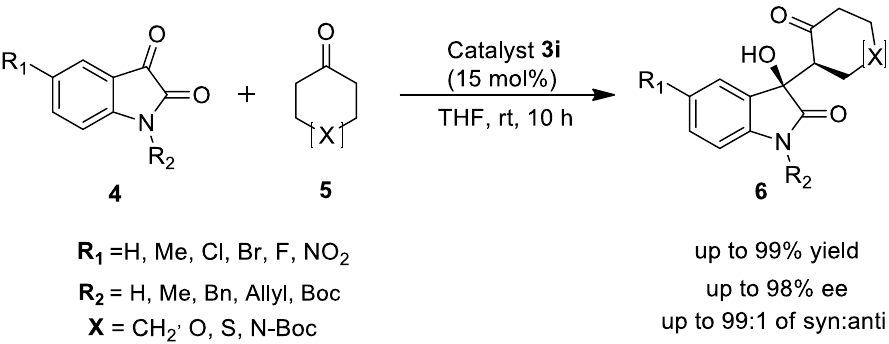
Figure 2. Structures and relative energies of intermediates I - 1 – 3 calculated at the B3LYP/6-311++G(d,2p)//B3LYP/6-31+G(d) levels of theory. Energy values are compared to the lowest-energy isomer I - 1 . Reprinted with permission from Ref. [69]. Copyright 2016, John Wiley and Sons.